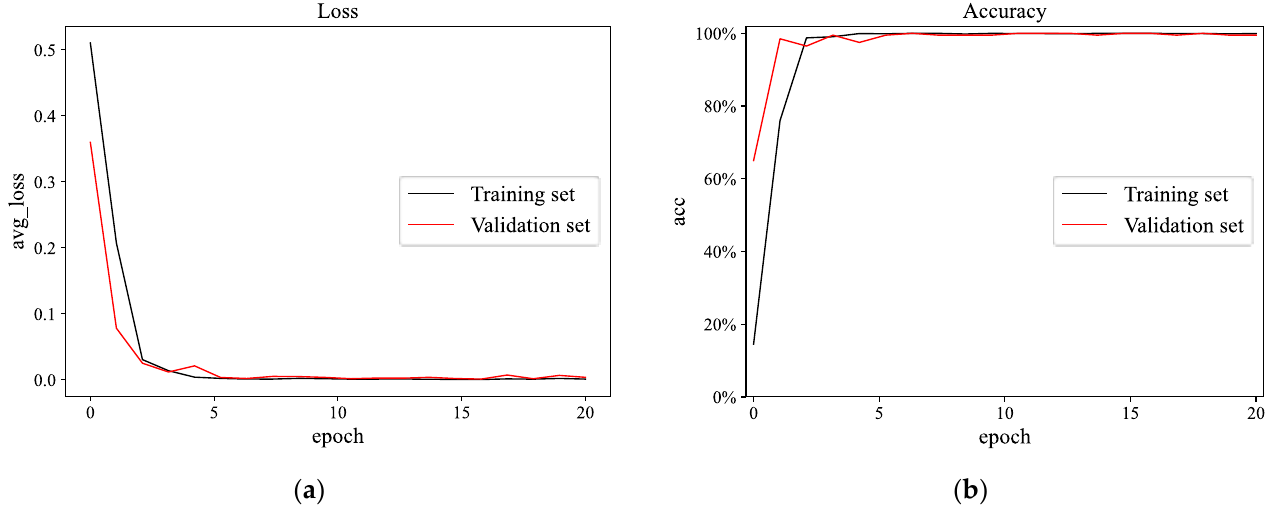
Figure 12. Time domain diagram of the simulated signal.